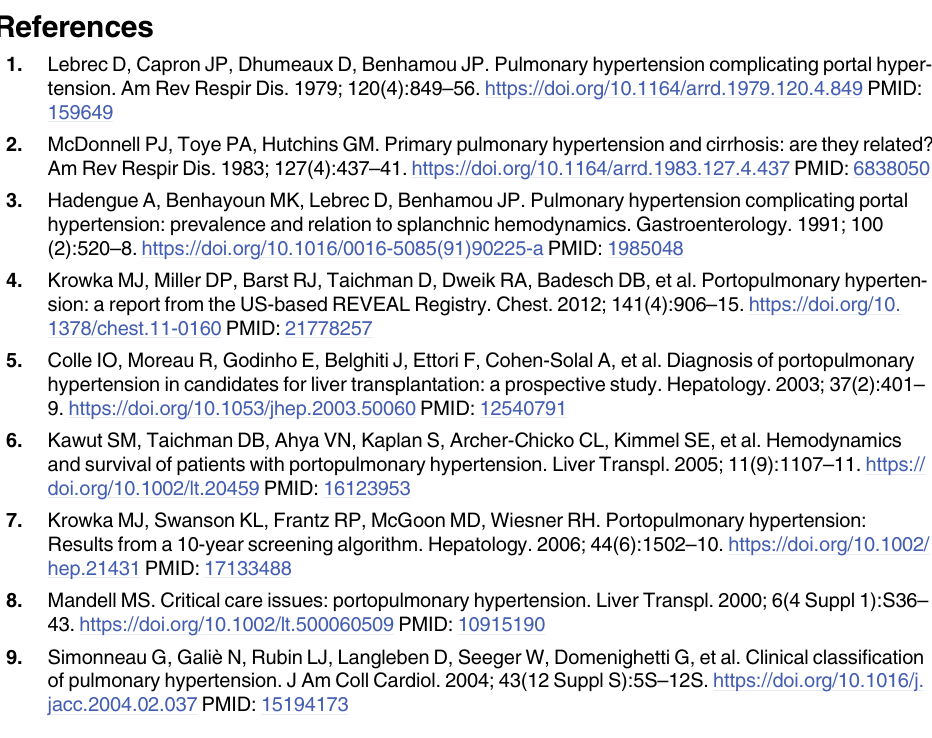
S2 Fig. About survival rate according to BNP level in LT and non-LT cases, there was no significant difference in the survival rate according to a BNP level. BNP, brain natriuretic peptide; LT, liver